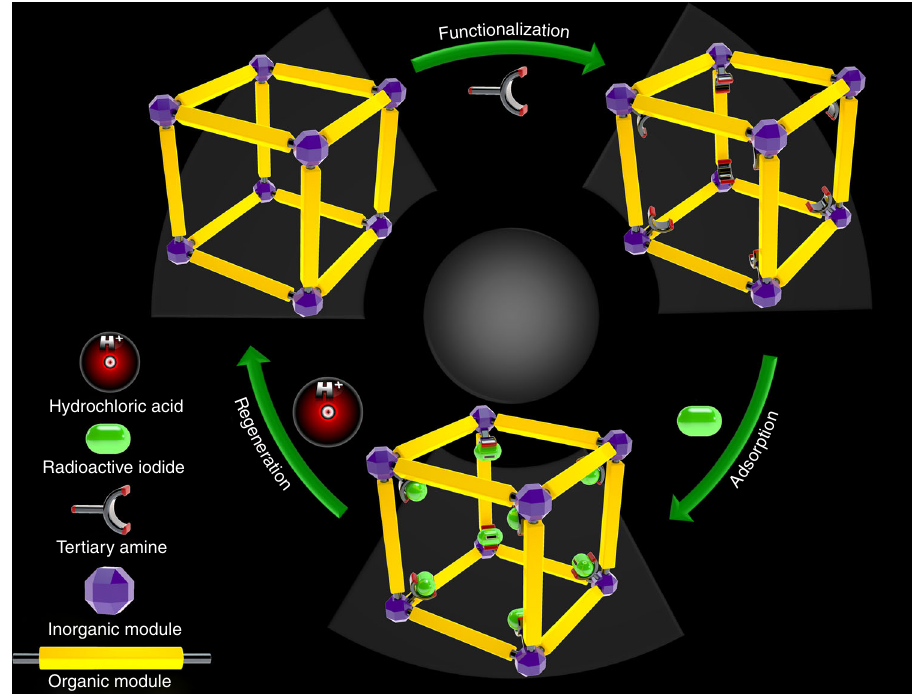
Fig. 1 The design strategy. A schematic illustrating the design of a recyclable MOF molecular trap for effective capture of radioactive organic iodides from nuclear